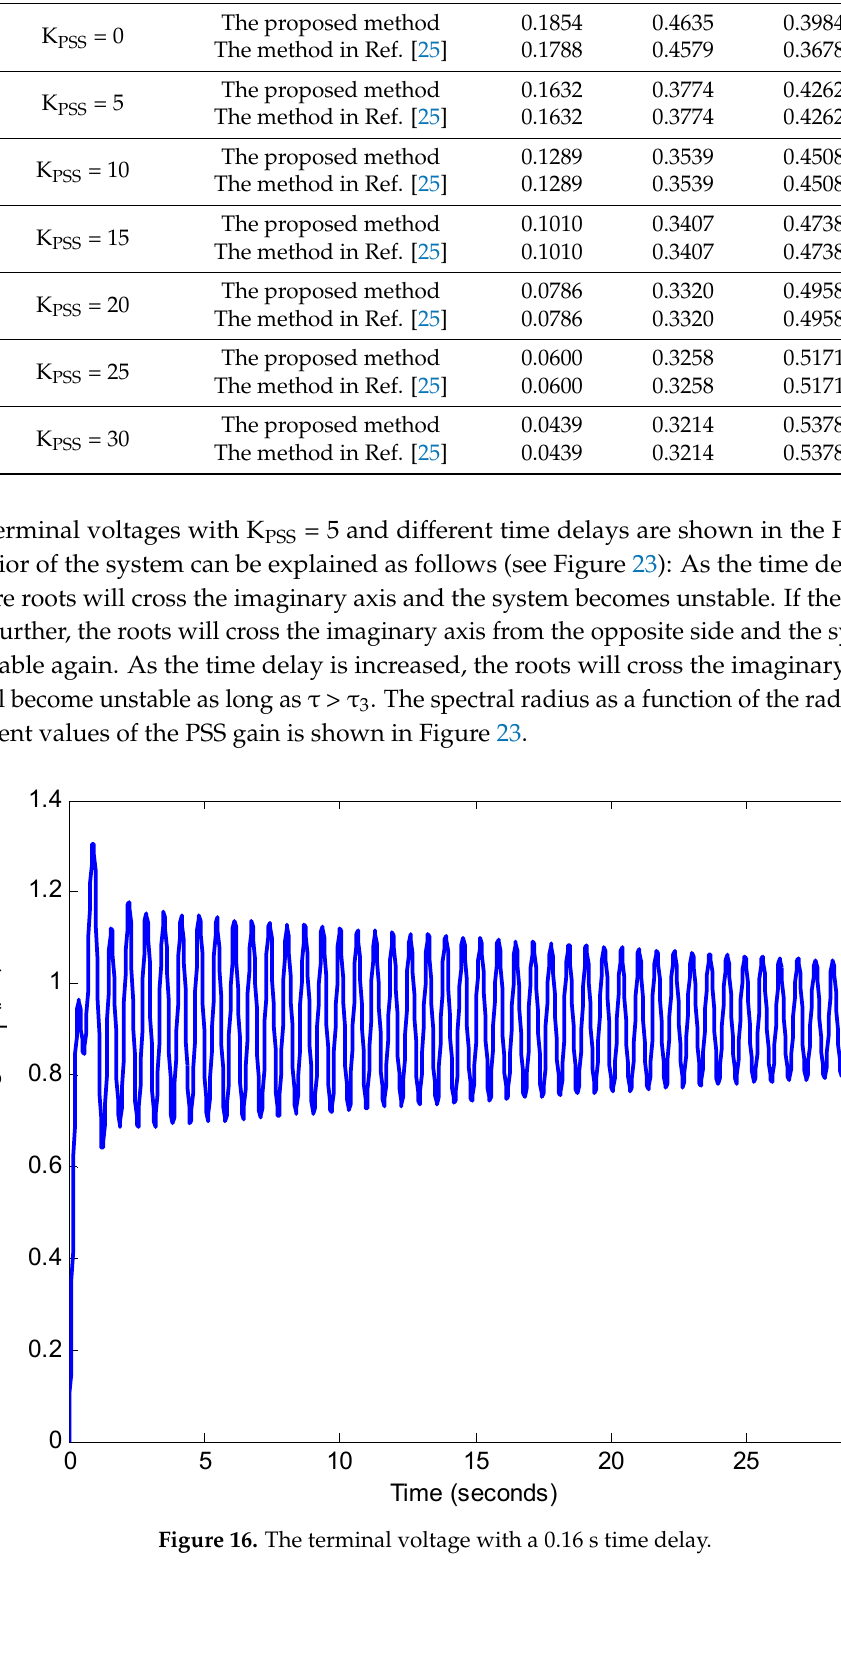
Figure 17. The terminal voltage with a 0.1632 s time delay.